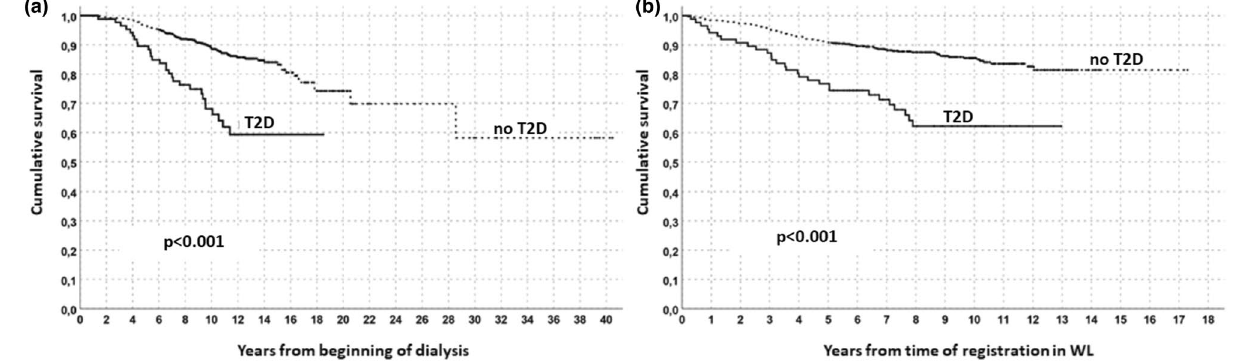
Figure 1. Survival analysis in the overall population (Kaplan–Meyer) according to T2D presence/absence. Follow/up start in ( a ) at the beginning of dialysis or in ( b ) at time of registration in WL.